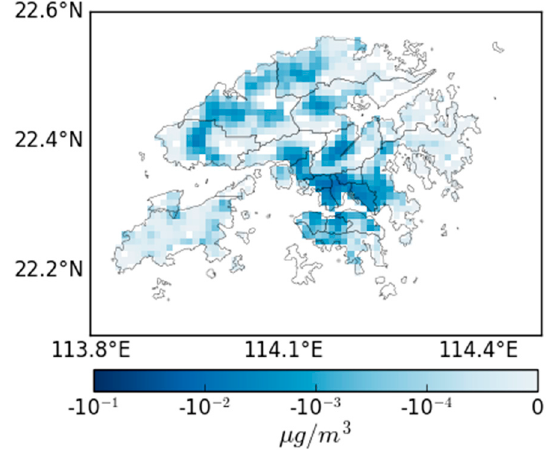
Figure 3. Spatial distribution of the reduction of the c ρ level of Hong Kong ( Δ c ρ ) in the 804 tests that reduced PM 2.5 concentration by − 1 μ g/m 3 in different pixels.